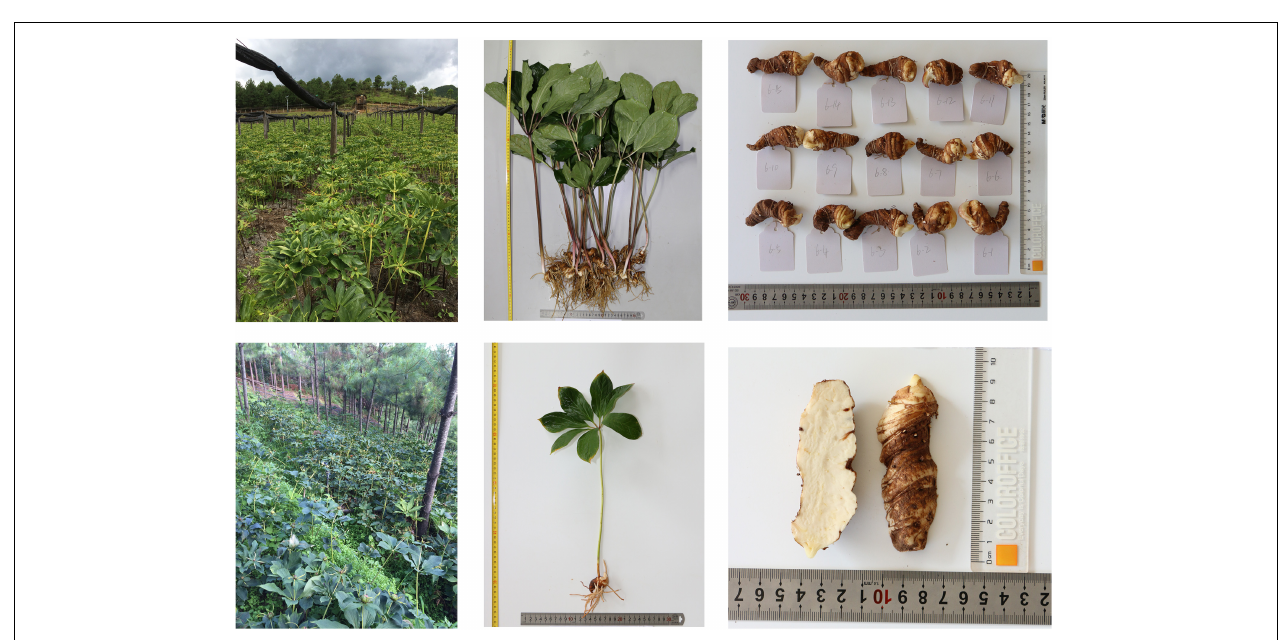
FIGURE 1 | Location distribution of Paris polyphylla var. yunnanensis samples in western, central, northwest, southwest and southeast of Yunnan.